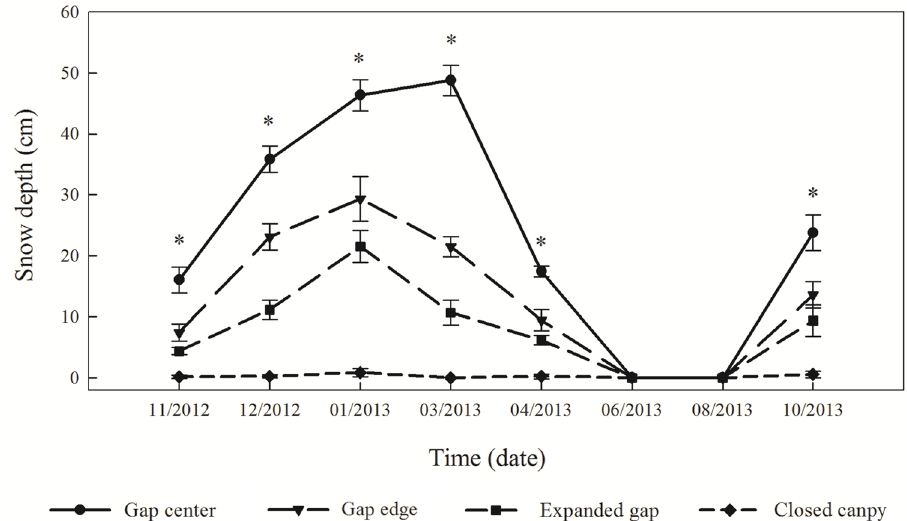
Figure 2. Snow depth (cm) on the four gap positions (gap center, gap edge, expanded gap, closed canopy) during the first year of litter decomposition in an alpine Minjiang fir forest. * indicate there are significant differences between different gap positions, p < 0.05 (mean ± SE, n = 3).